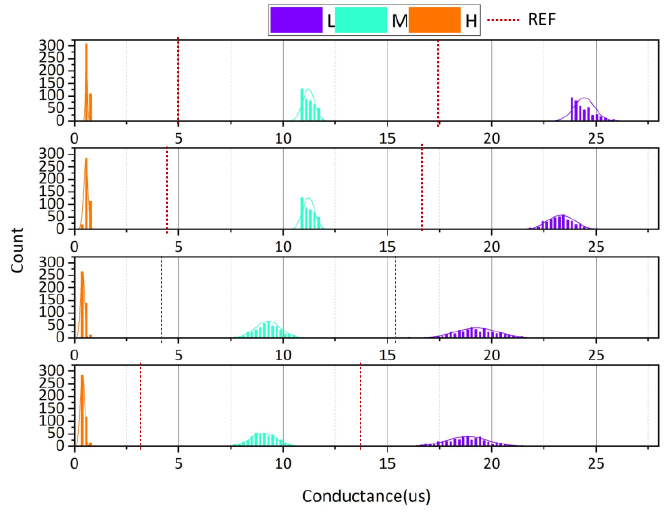
Figure 11. The conductance drift of the proposed 2T2R structure in 8 states.